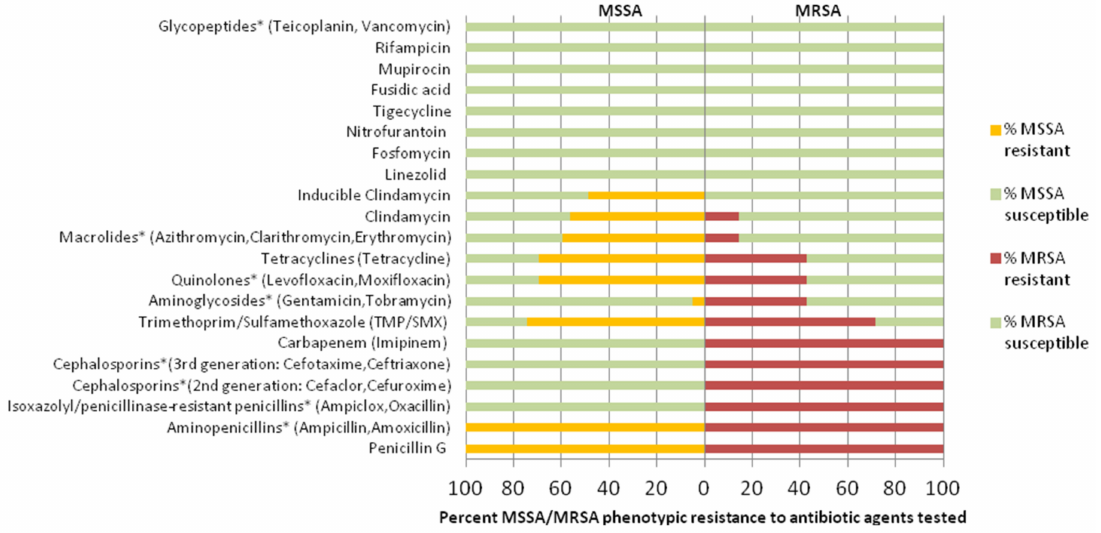
Figure 3. Antibiotic class/agent-specific resistance profiles of nosocomial infection-related MSSA ( n = 40) and MRSA ( n = 7) in the form of a gapped population pyramid (MSSA left; MRSA